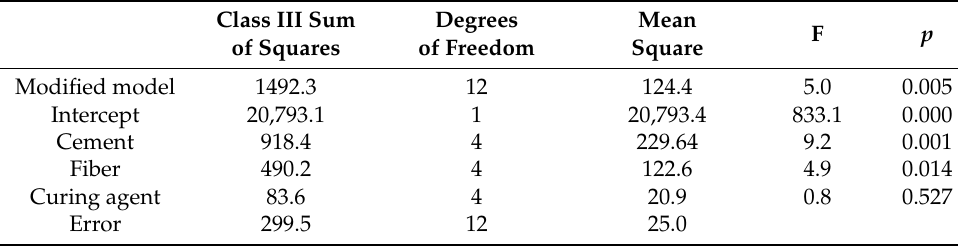
Table 5. Results of variance analysis of internal friction